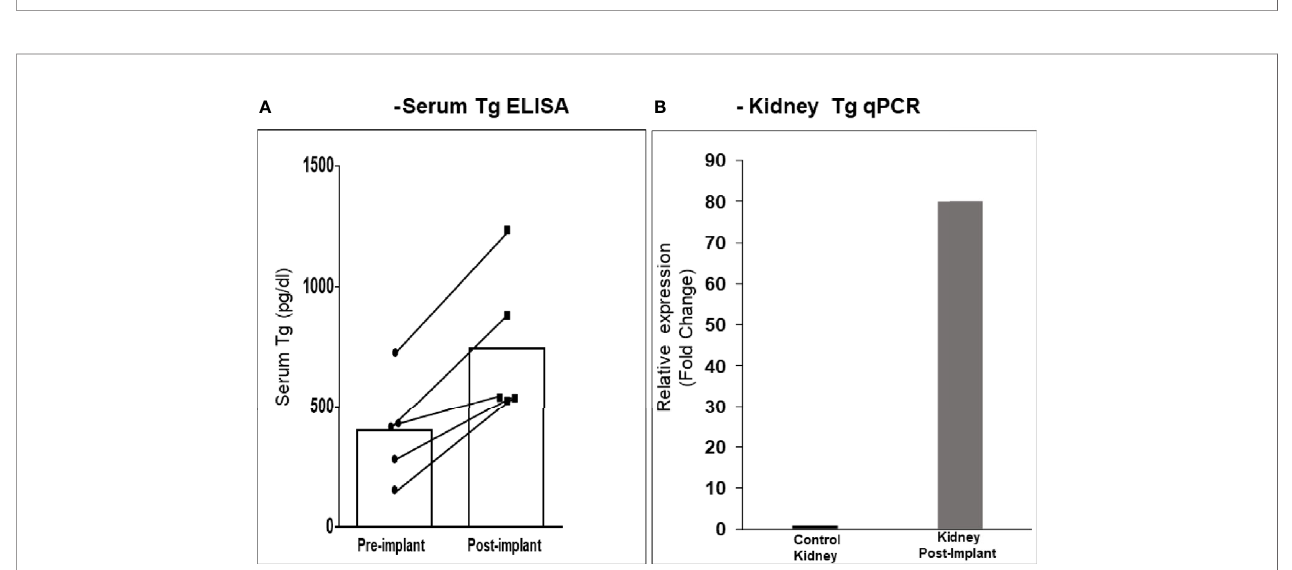
FIGURE 9 | Serum Tg and renal Tg mRNA in transplanted mice. (A) The kidney implanted mouse sera showed elevated levels of circulating Tg compared to the pre-bleed sera when measured by ELISA. (B) Kidney tissue from mice at 20 weeks was analyzed by qPCR for Tg mRNA expression. As indicated a ~ 80-fold increase in expression was observed in kidney implanted animals versus control kidney. Since the tissue was from a limited number of animals (n = 3) a statistical evaluation could not be